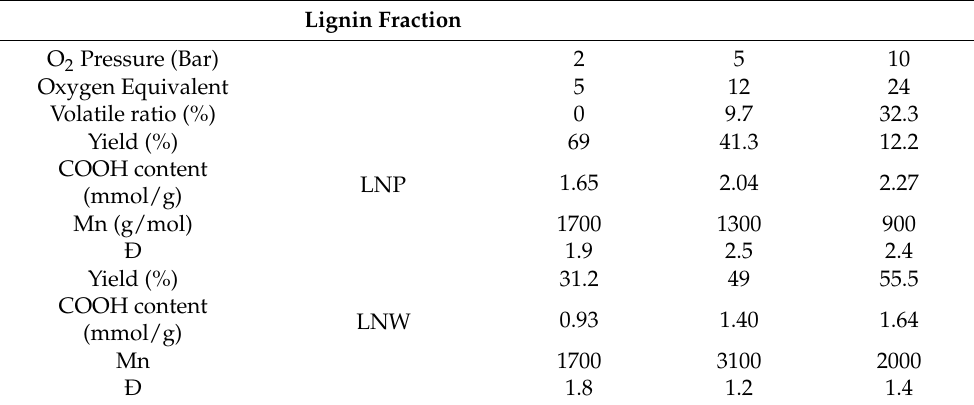
Table 2. Effect of oxygen pressure on the oxidative depolymerization of LN1 (180 ◦ C, 1 h); precipitated lignin (LNP), hydrosoluble lignin (LNW).